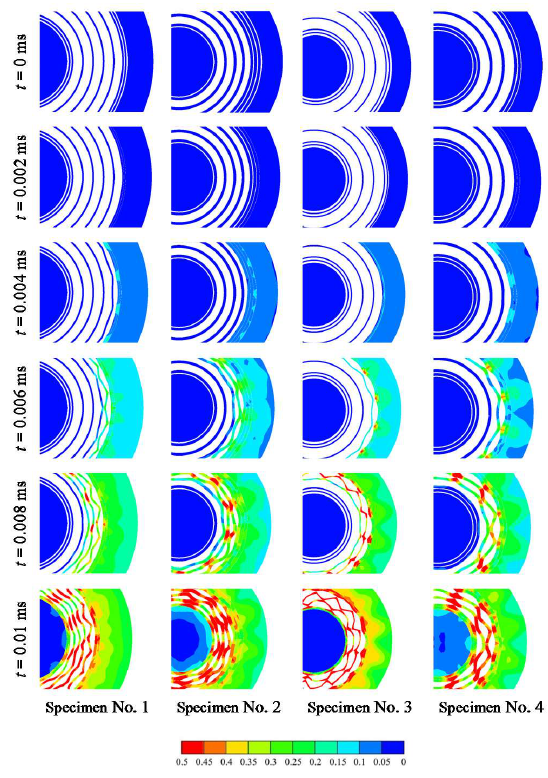
Figure 5. Simulation of the deformation process during explosive compaction of the four aluminium UniPore samples (Table 1) with annotated effective plastic strain.